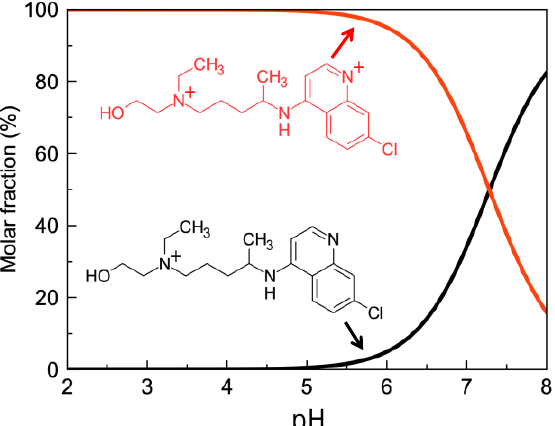
Figure 5. Bjerrum speciation plot for HCQ across the pH range encountered in vivo. Calculations performed using ChemAxon [25] which estimates a pK a = 7.28 (quinoline) and 9.76 (ternary nitrogen) for HCQ.